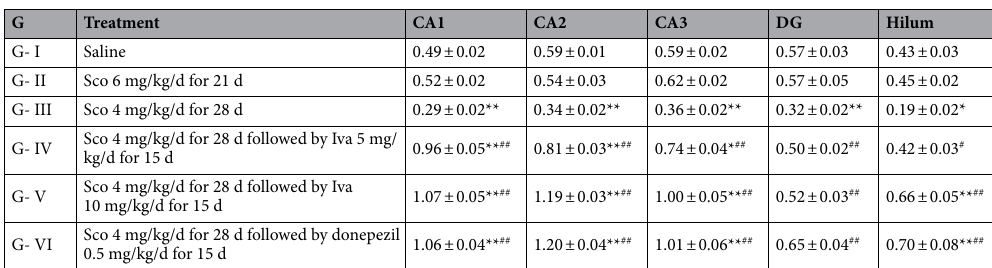
Table 4. Summarizing the optical density of HCN1 immunoreactivity in various HC subfields (CA1, CA2, CA3, DG, and hilum) in different groups: Values are expressed as mean ± SEM of (8–10) rats. Analyzed using by one way ANOVA p < 0.01. *Significant (P > 0.05) and **highly significant (P > 0.01) difference from control group. # Significant (P > 0.05) and ## highly significant (P > 0.01) difference from dementia control